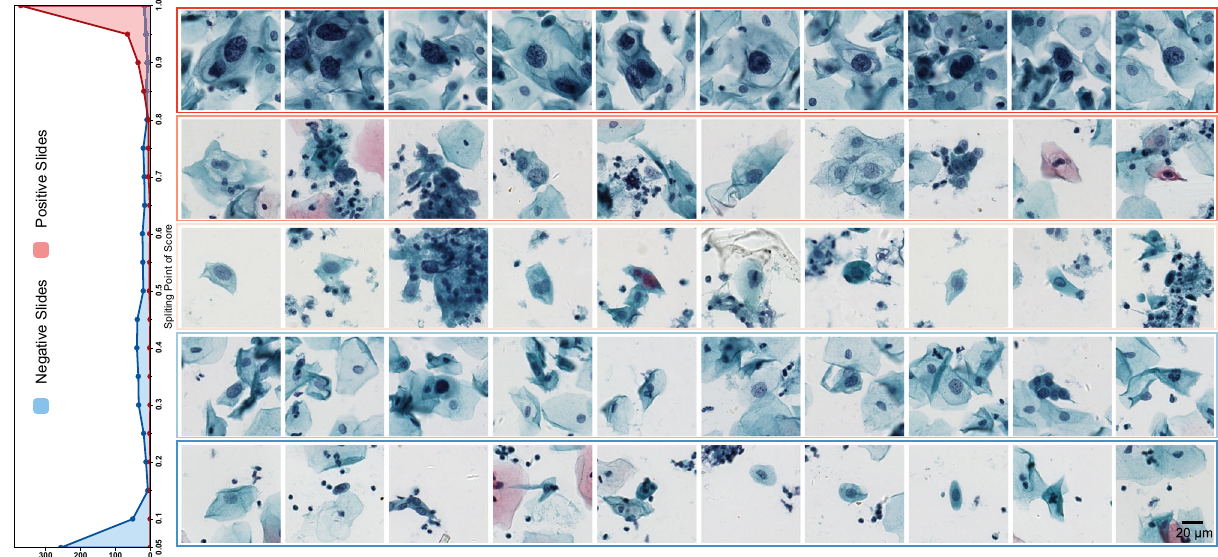
Fig. 4 The recommended top 10 lesion cells of WSIs with different classi fi cation scores. The left subgraph is the frequency histogram of slide scores from 0 to 1 with an interval of 0.05 in groups E and F ( n = 1,170). The right subgraph is the recommended top 10 lesion cells of slides with different scores.